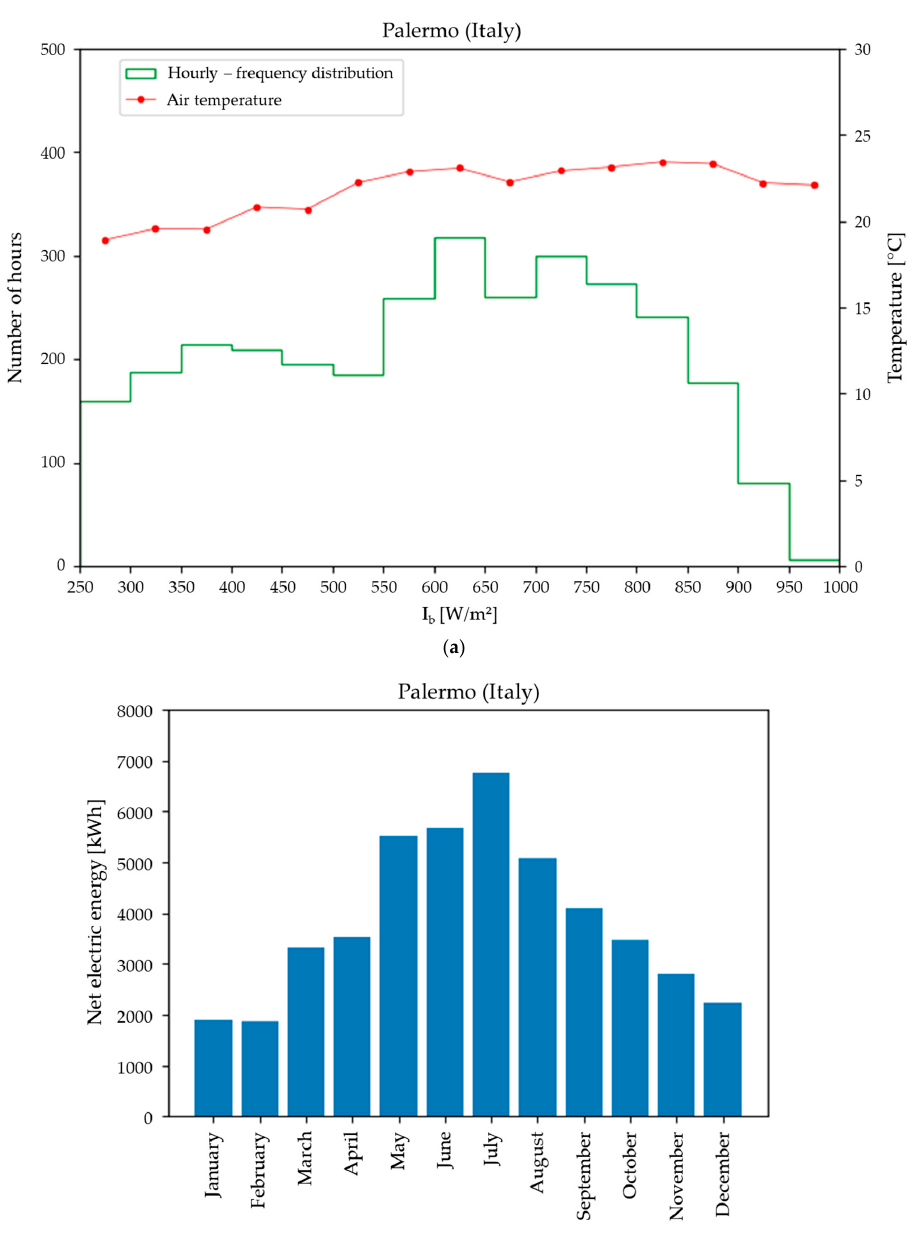
I and average air temperature for Palermo and ( b ) monthly b